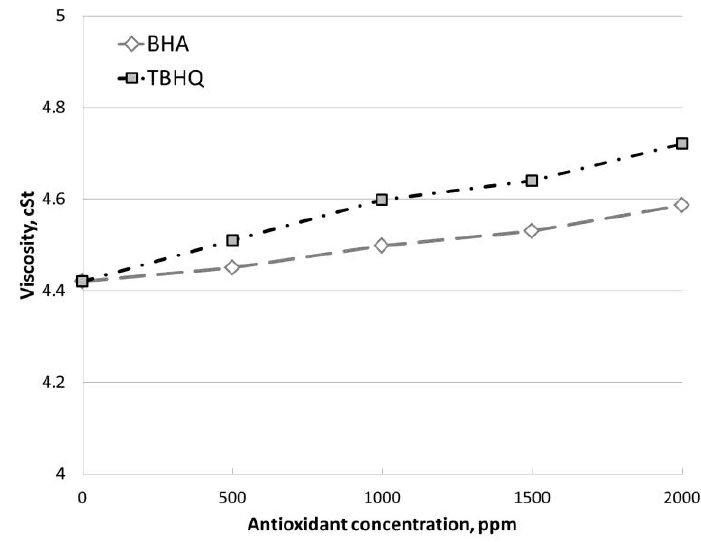
Figure 8. E ff ect of BHA and TBHQ on viscosity of sa ffl ower Figure 8. Effect of BHA and TBHQ on viscosity of safflower biodiesel.